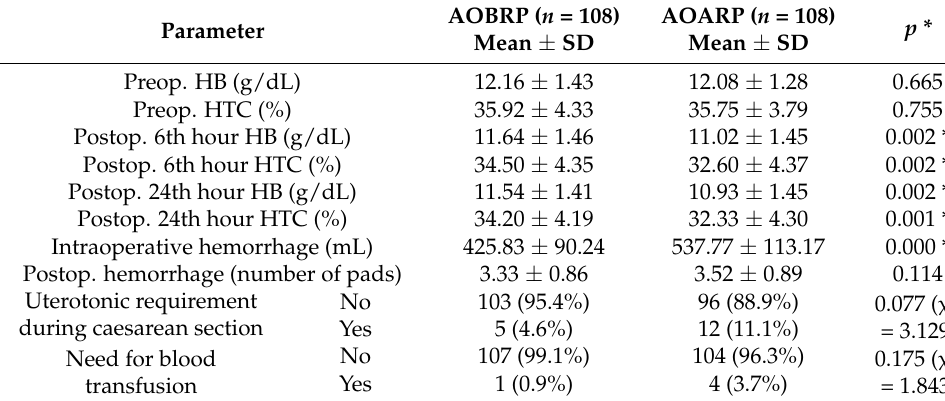
Table 2. Comparison of the hemorrhage parameters between the two groups. AOBRP ( n = Parameter